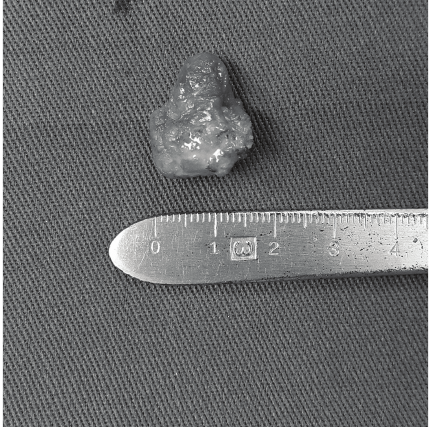
Figure 4: Specimen after